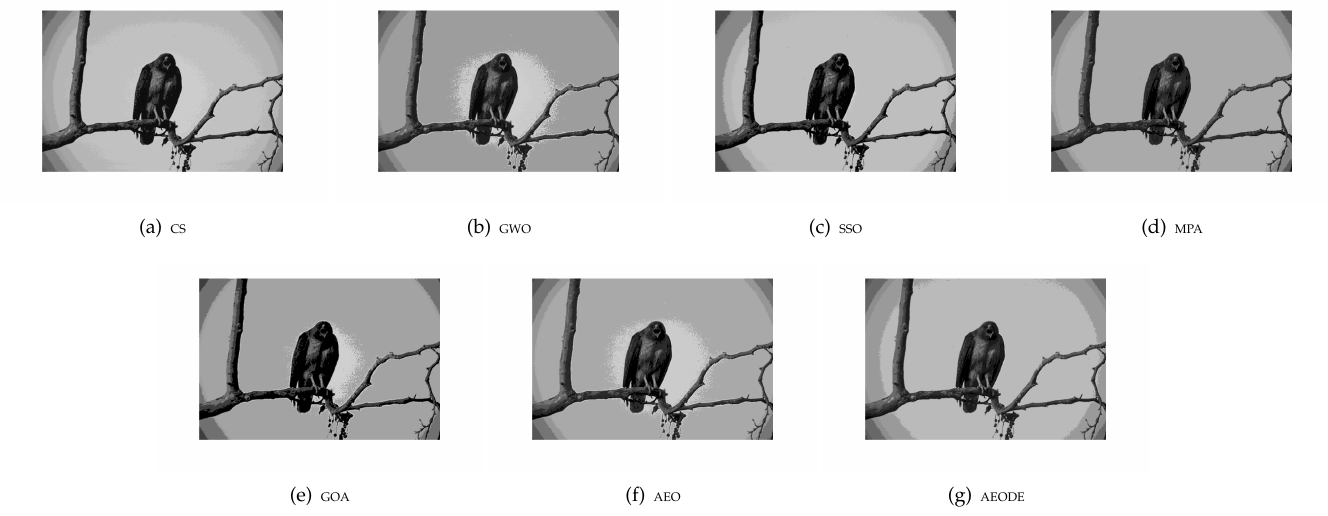
Figure 9. Segmentation results at threshold level 19 for the images I10.